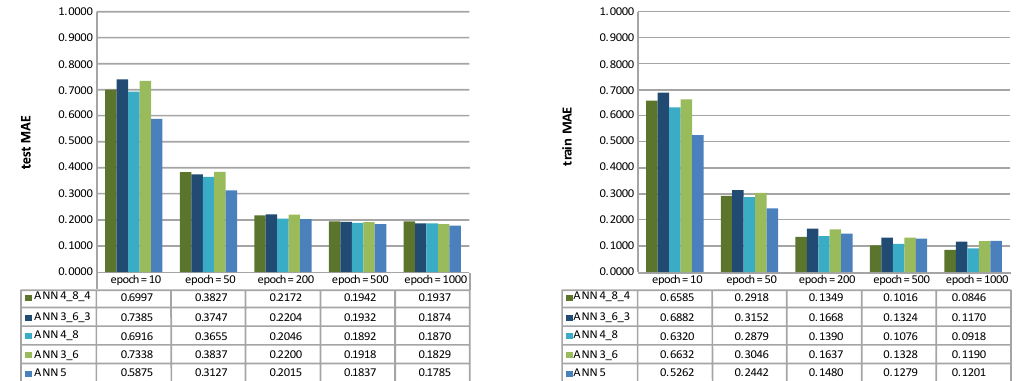
Figure 4. Test ( left ) and train MAE ( right ) of five different ANN topologies; ANN 5, ANN 3_5, ANN 4_8, ANN 3_6_3, and ANN 4_8_4.